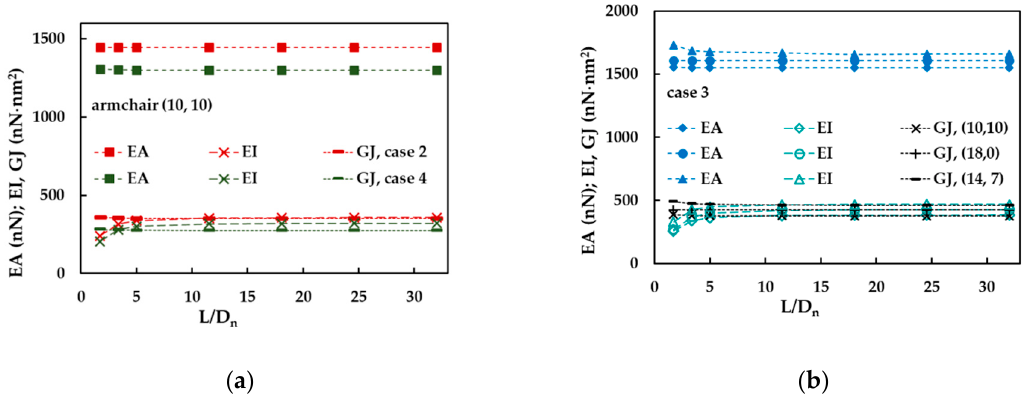
Figure 7. The evolutions of the ratios ( a ) (EI/EA) ⋅ (1/D n3 ) and ( b ) EI/GJ with the nanotube diameter, D n , for case 3.